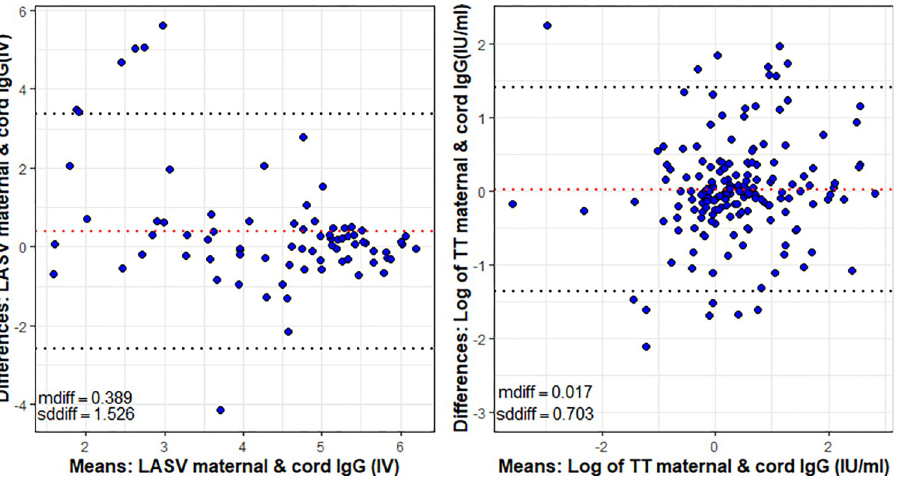
Fig 4. Bland-Altman plot showing agreement between maternal and cord Lassa and TT IgG antibodies. Note: IV- index value; dotted black lines indicate limits of agreement ( ± 2sddiff); dotted red line indicates mean difference between maternal and cord concentrations; mdiff- mean difference; sddiff- standard deviation of